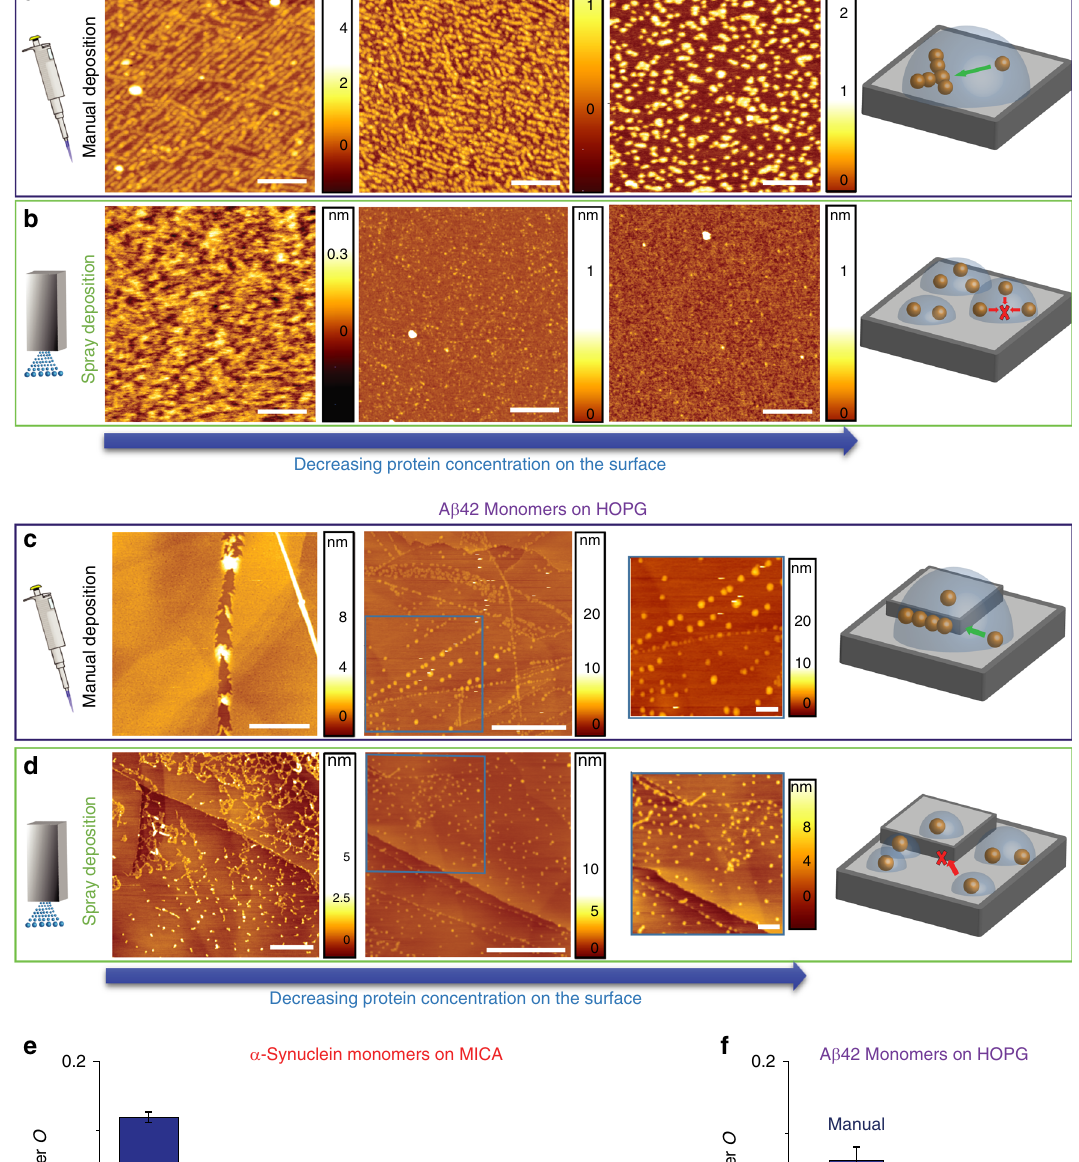
NATURE COMMUNICATIONS| (2018) 9:3890 |DOI: